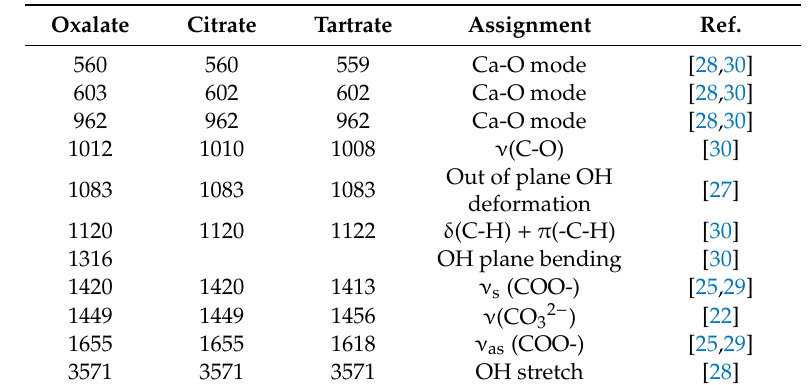
Table 4. The wavenumbers (cm − 1 ) and assignments for oxalate, citrate and tartrate ions on the hydroxyapatite